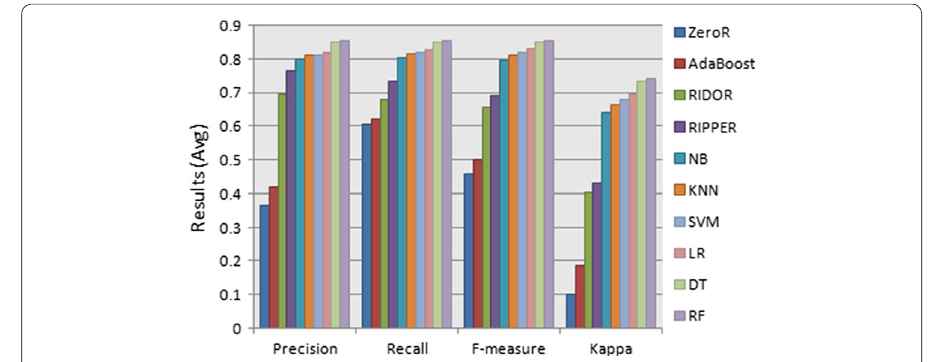
Fig. 3 Effectiveness comparison results (average) for different machine learning classifier based context-aware models utilizing a collection of